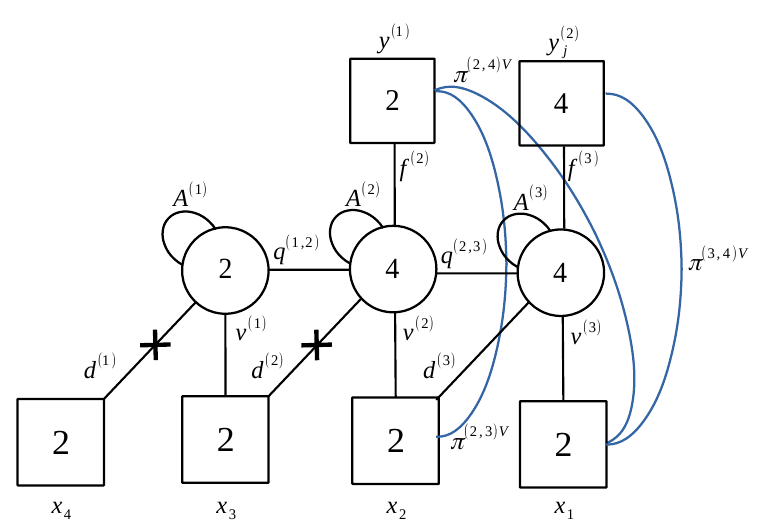
and (cid:13) _ , 11 21